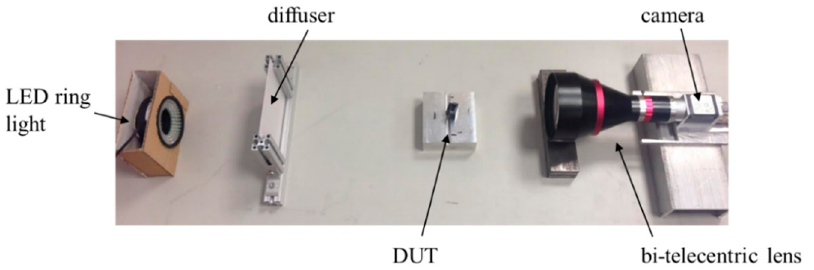
Figure 1. The experimental setup of the machine vision system.